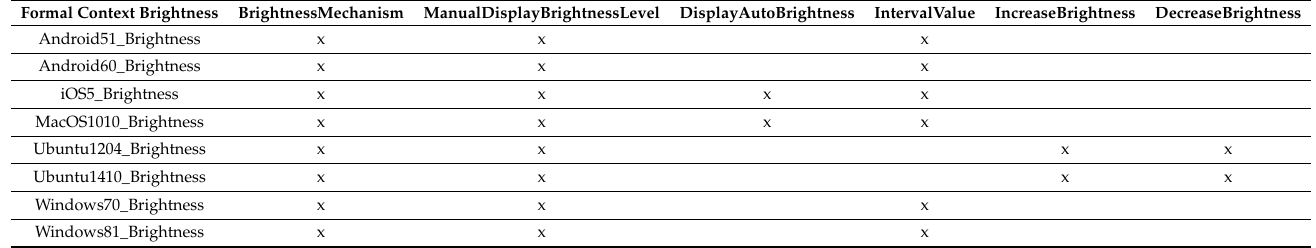
Table 2. Brightness mechanism formal